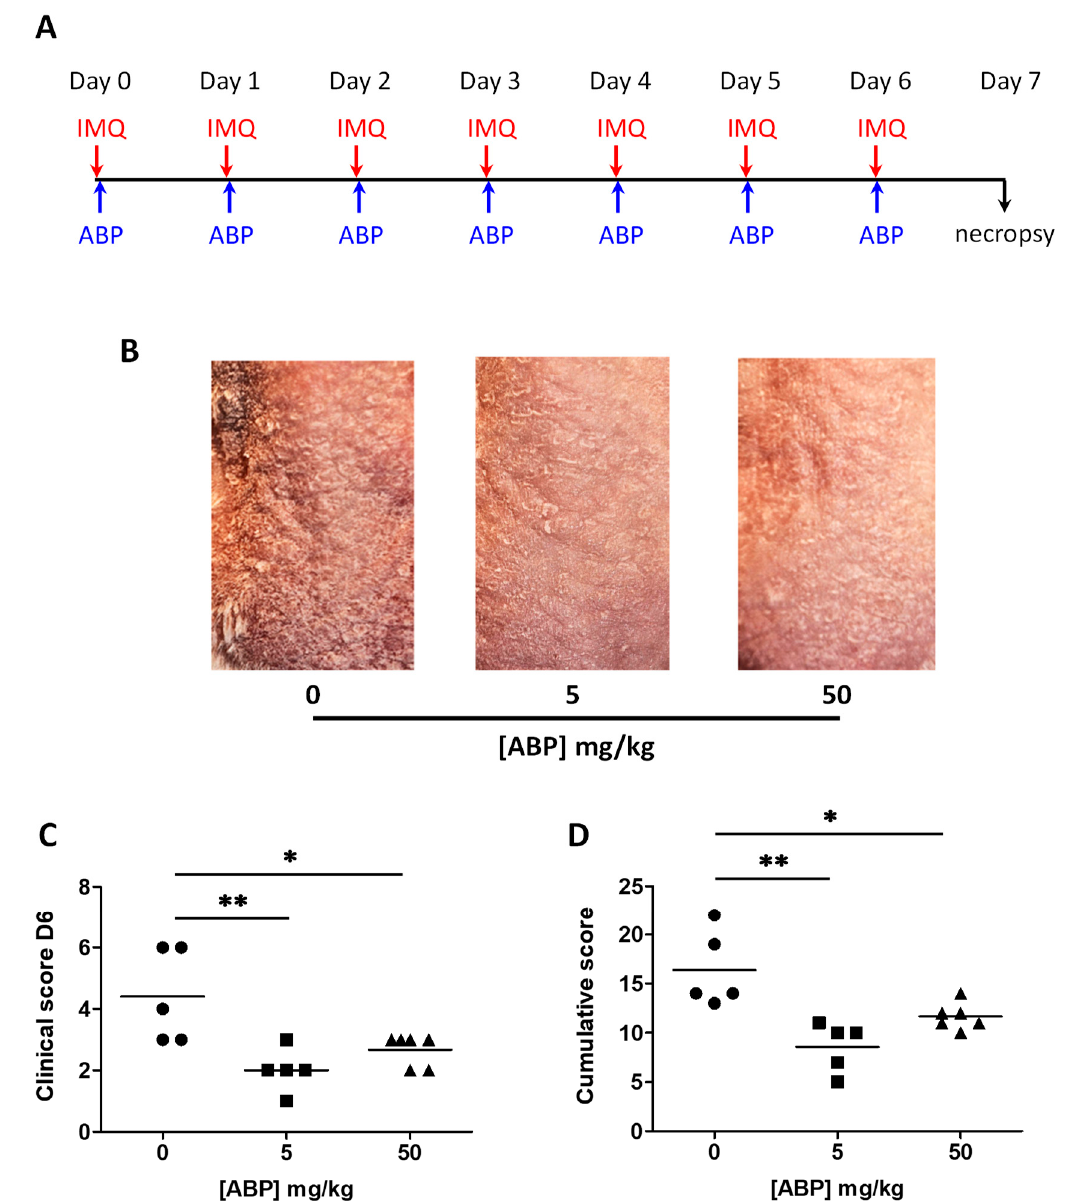
Figure 4. Clinical assessment of the efficacy of the ABP dendrimer when administered topically to IMQ-induced psoriatic mice. ( A ) Time line of the study. ( B ) Representative pictures of the skin of the back of mice. On the left, control psoriatic mouse; in the middle and on the right, mouse treated daily with 5 mg / kg and 50 mg / kg of the ABP dendrimer, respectively. ( C ) Clinical score at day 6 for each group of mice ( n = 5 mice in the control group at a concentration of ABP = 0 mg / kg, n = 5 mice for the group at 5 mg / kg, and n = 6 mice for the group at 50 mg / kg). ( D ) Cumulative clinical score from day 1 to day 7 for each group of mice. * p < 0.05, and ** p < 0.01 versus untreated mice (concentration of ABP = 0 mg / kg) using the one-way ANOVA test followed by the post hoc Dunnett’s